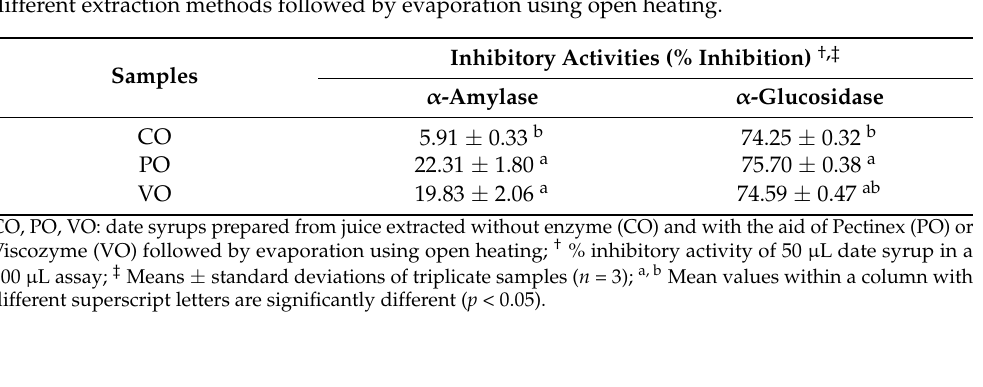
Table 5. Inhibitory activities on carbohydrate digestive enzymes of date syrups prepared using different extraction methods followed by evaporation using open